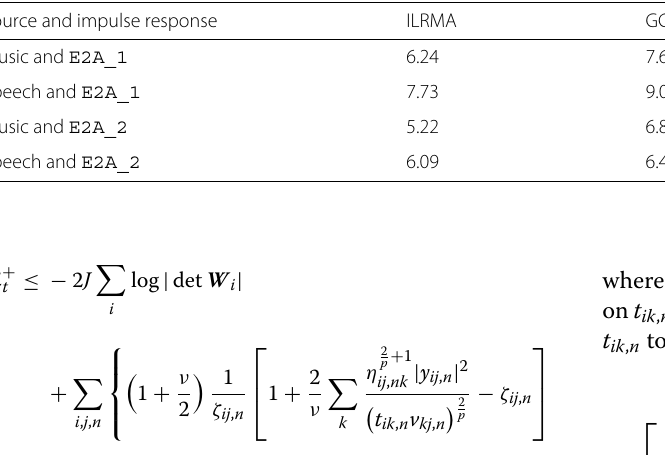
Table 6 Overall average SDR improvements (dB) in two-source case employing parameter tempering for the best parameter settings